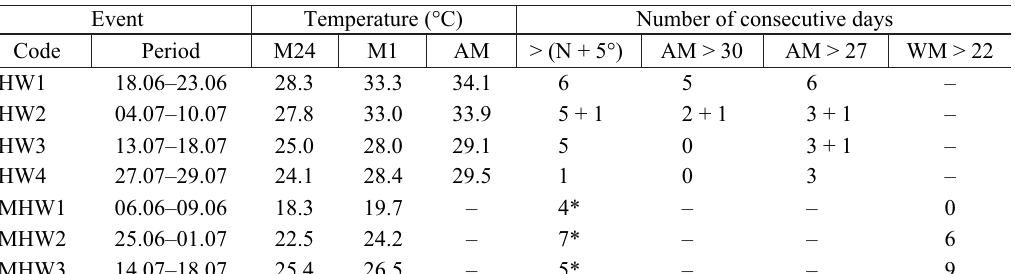
Table 1. The HW (Kunda weather station) and MHW (Kunda coastal station) events in 2021. Air (AT) or water (WT) temperatures (°C): M24 – maximum 24-h average, M1 – maximum 1-h average, AM – absolute